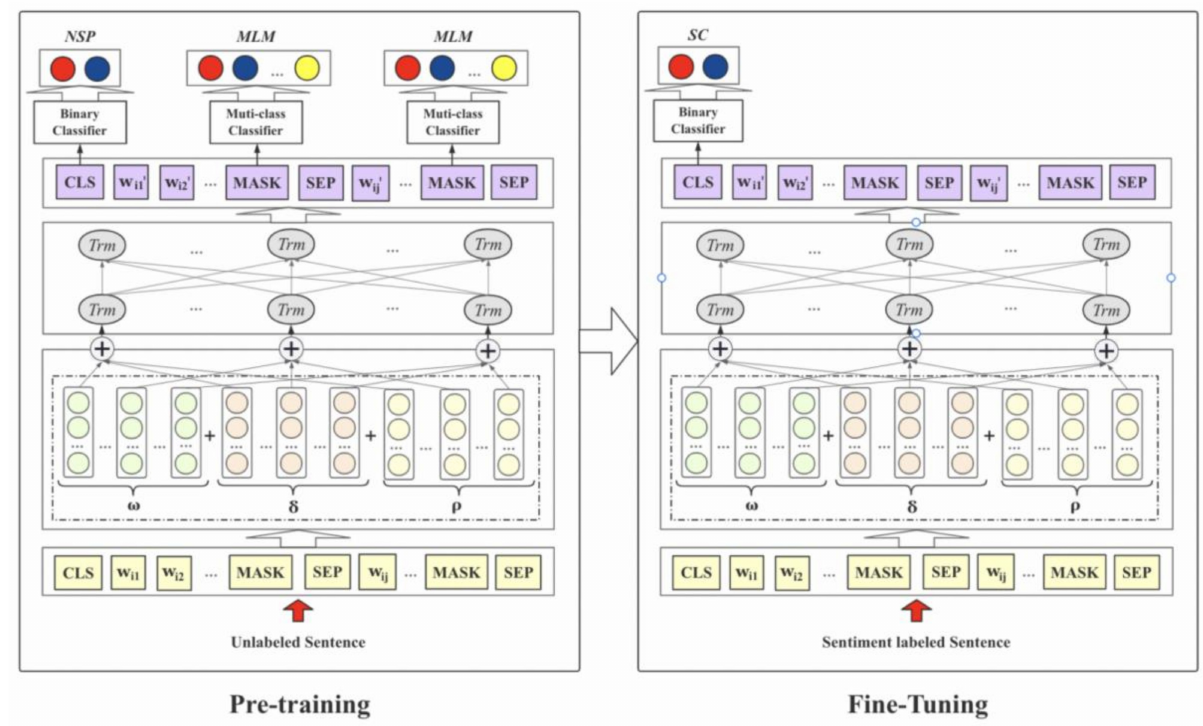
Figure 2. Structure of sentiment classification by Bert deep learning